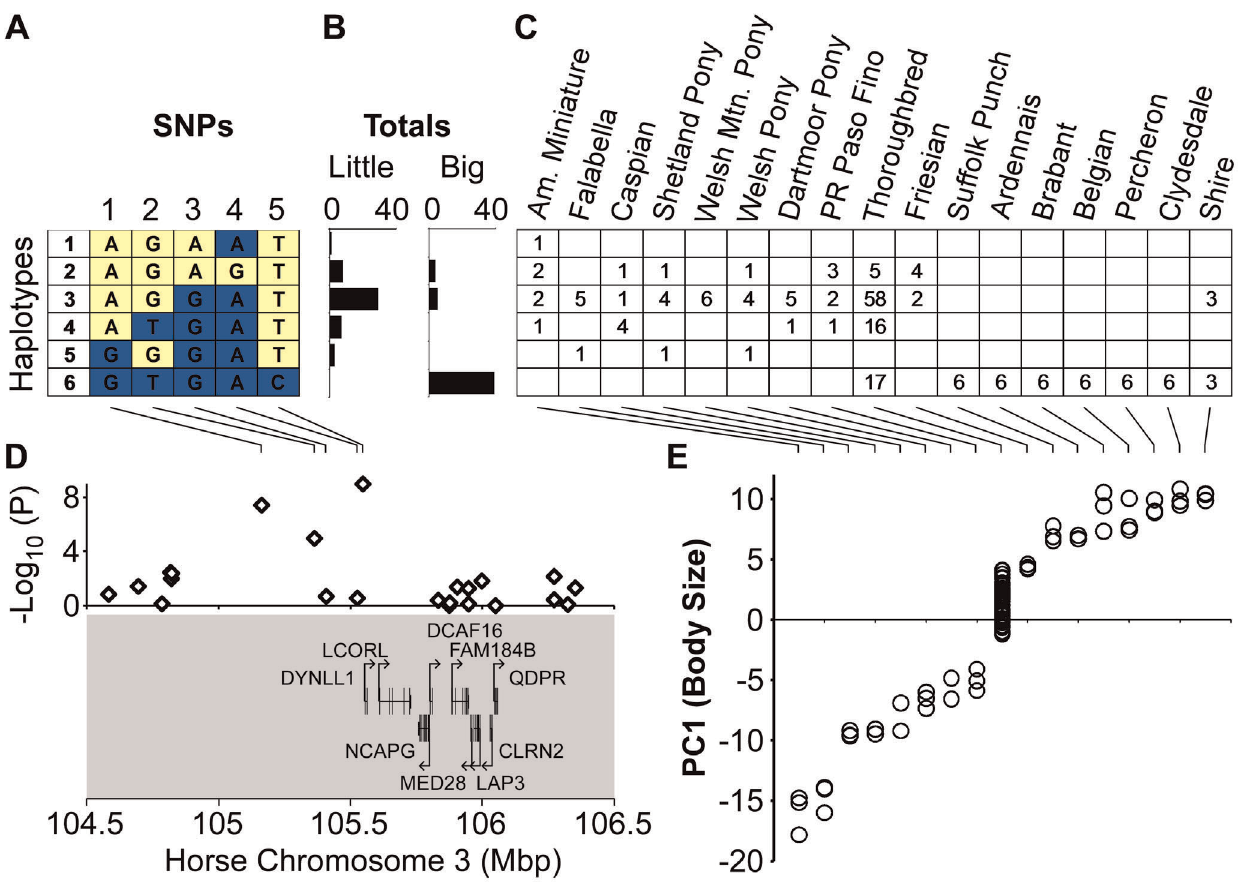
Figure 3. Haplotypes at the LCORL locus on horse chromosome 3 are associated with size. (A) Haplotypes for five SNPs were inferred with PHASE and (B) have different counts in the set of all little breed horses (American Miniature to Puerto Rican Paso Fino) vs. all big breed horses (Friesian to Shire). (C) For each breed, the count of chromosomes inferred to be carrying each haplotype. (D) Size-associated SNPs on chromosome 3 are adjacent to the LCORL gene. SNP associations from the 16-breed GWA scan are plotted above the genes in this locus. Each gene’s exons (vertical bars), introns (horizontal lines) and direction of transcription (arrow) are indicated. (E) The size of each horse was quantified via a principal components analysis of 33 measurements from the head, neck, trunk and limbs. For each horse, breed membership is plotted vs. PC1-size